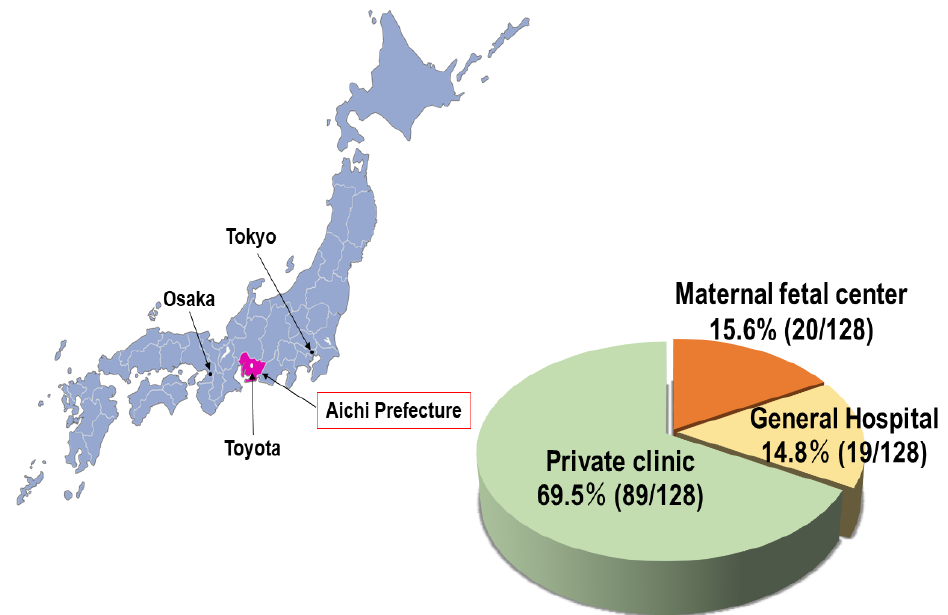
Figure 1. The system of maternity care units in Aichi Prefecture. Most maternity care was provided by private clinics. The map was created by Japanese Map Maker (https://www.start-point.net/maps/map_maker/Public Day (accessed on 8 October 2020 18:39:43) (last updated on 8 October 2020